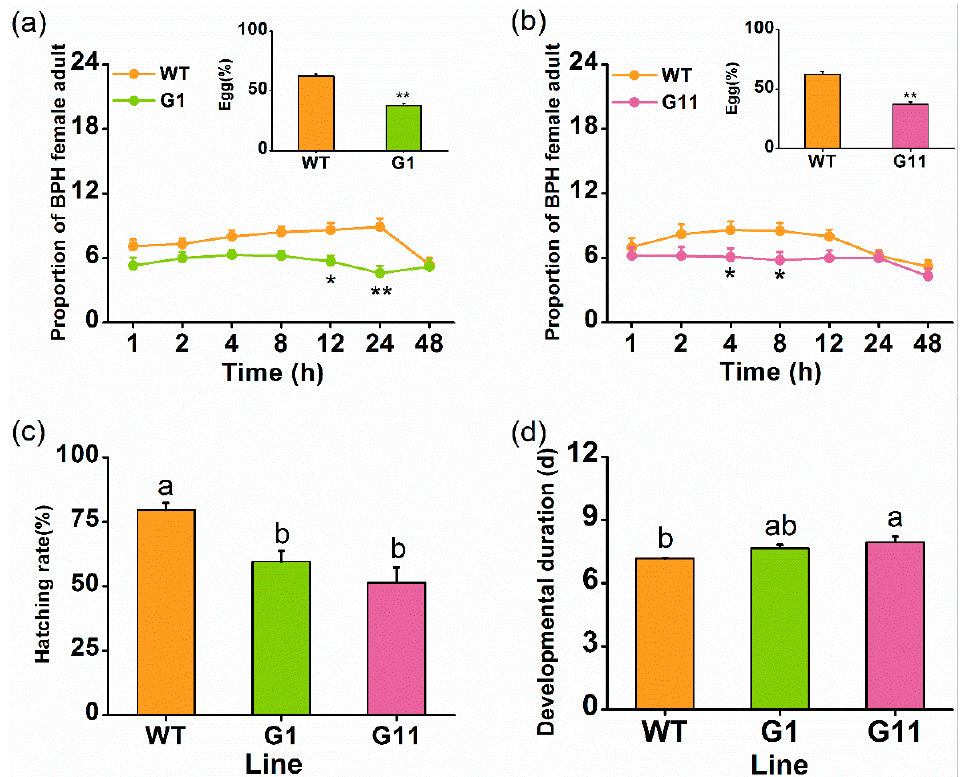
Figure 3. OsGID1 positively mediates rice resistance to BPH. ( a , b ) Mean number of gravid BPH females per plant (+SE, n = 10) on pairs of plants (WT versus G1 or G11) in two-choice assays, 1–48 h after pairs were exposed to the herbivore. Inserts: Mean percentage of BPH eggs per plant (+SE, n = 10) on pairs of plants as stated above, 48 h after the release of BPH. ( c ) Mean hatching rate (+SE, n = 10) of BPH eggs on WT and oe-GID1 plants; ( d ) Mean developmental duration (+SE, n = 10) of BPH eggs on WT and oe-GID1 plants. Asterisks indicate significant differences in oe-GID1 plants, compared with WT plants (* p < 0.05, ** p < 0.01, chi-square test); different letters indicate significant differences between oe-GID1 lines and WT plants (Duncan’s multiple range test, * p < 0.05).